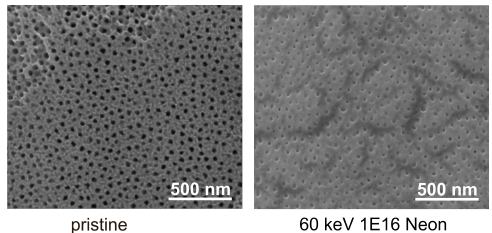
Figure 3. SEM images of NT arrays before and after Ne bombardment with an acceleration energy of 60keV and a fluence of 1 × 10 16 ions/cm 2